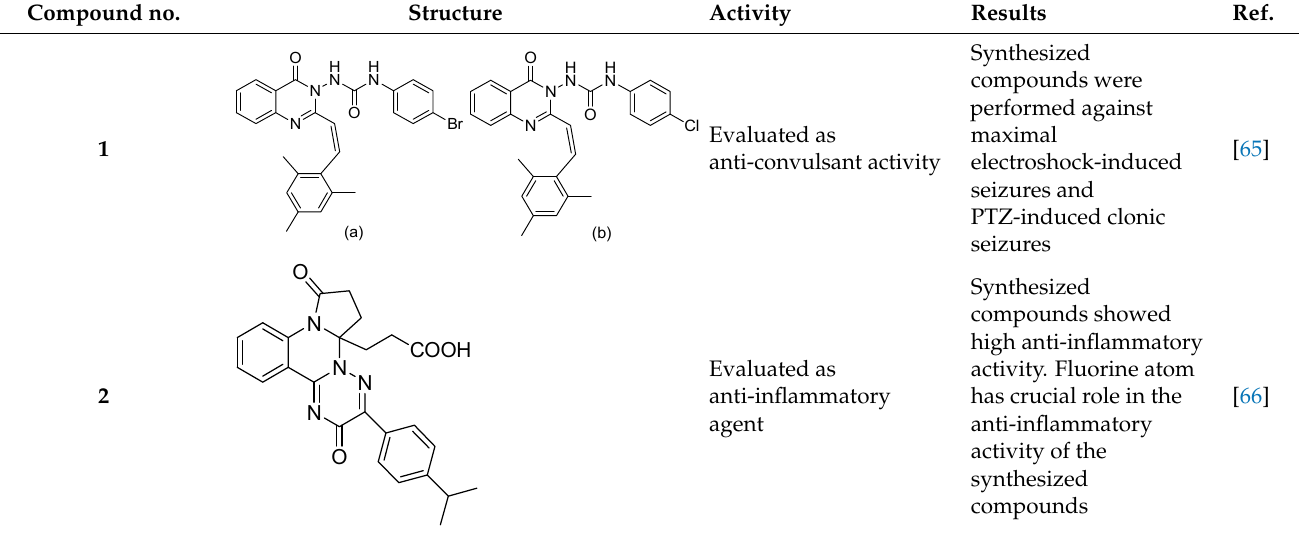
Table 7. Miscellaneous activities of quinazoline derivatives.